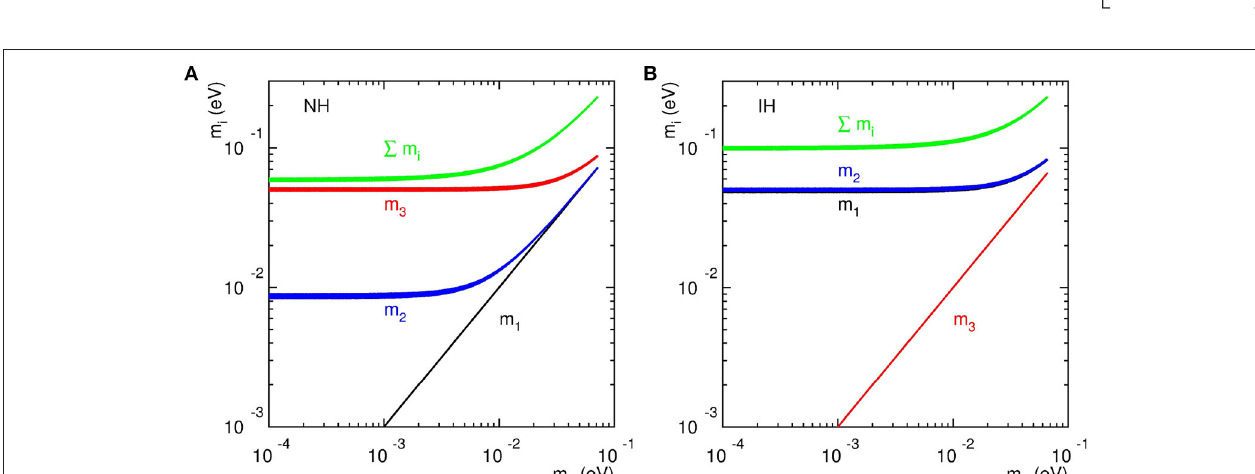
FIGURE 1 | The three active neutrino mass spectra vs. the lowest neutrino mass for (A) NH and (B)